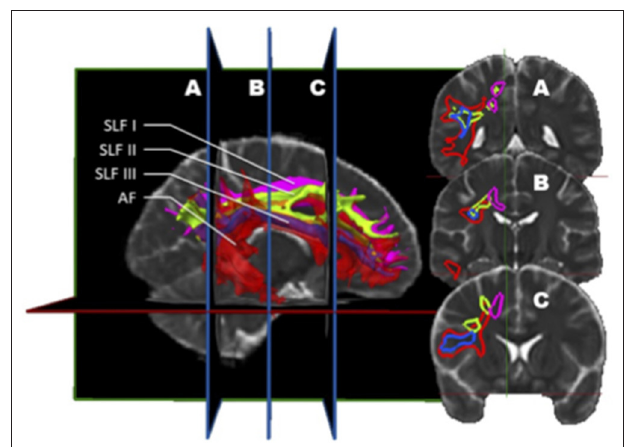
FIGURE 4 | In vivo fiber tractography of the right SLF I (pink), SLF II (green), SLF III (blue), and AF (red) represented by volume. A three-dimensional reconstruction of these bundles is displayed at the left of the figure. The AF is slightly transparent to let appear the SLF III, being inside the latter. On the right, the coronal sections (A, B, and C) are represented. This figure confirms that the SLF III also corresponds to a sub-division of the AF. Indeed, throughout its length, the SLF III is located inside the